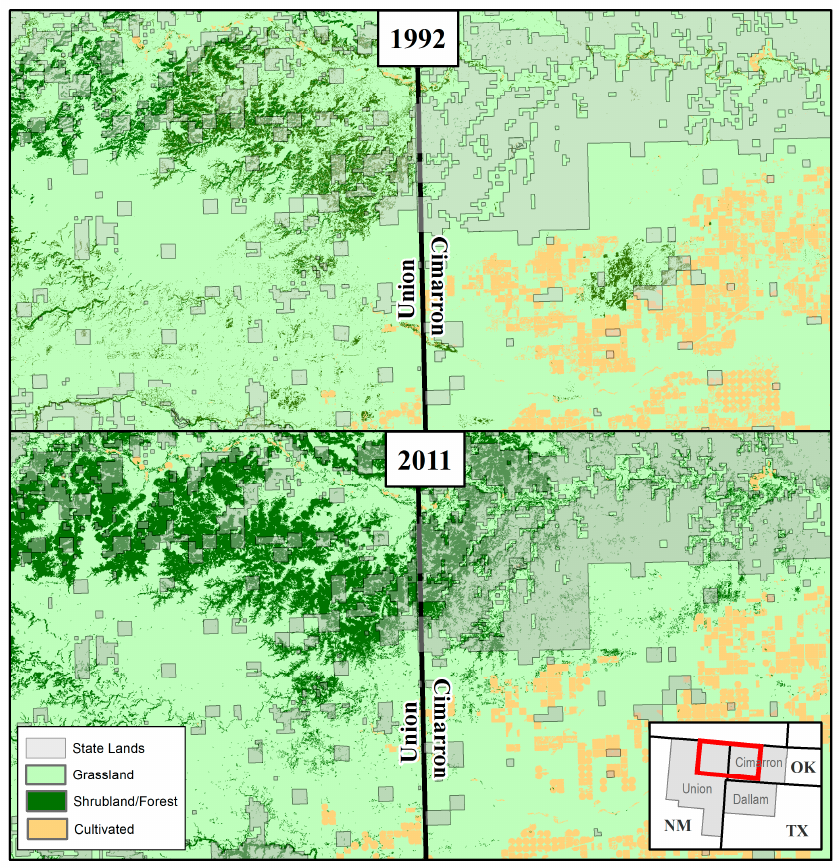
Figure 4. Example of woody plant encroachment across the New Mexico (Union Co.)-Oklahoma (Cimarron Co.) state line in 1992 and 2011. Source: Figure created by the authors using the National Land Cover Database.